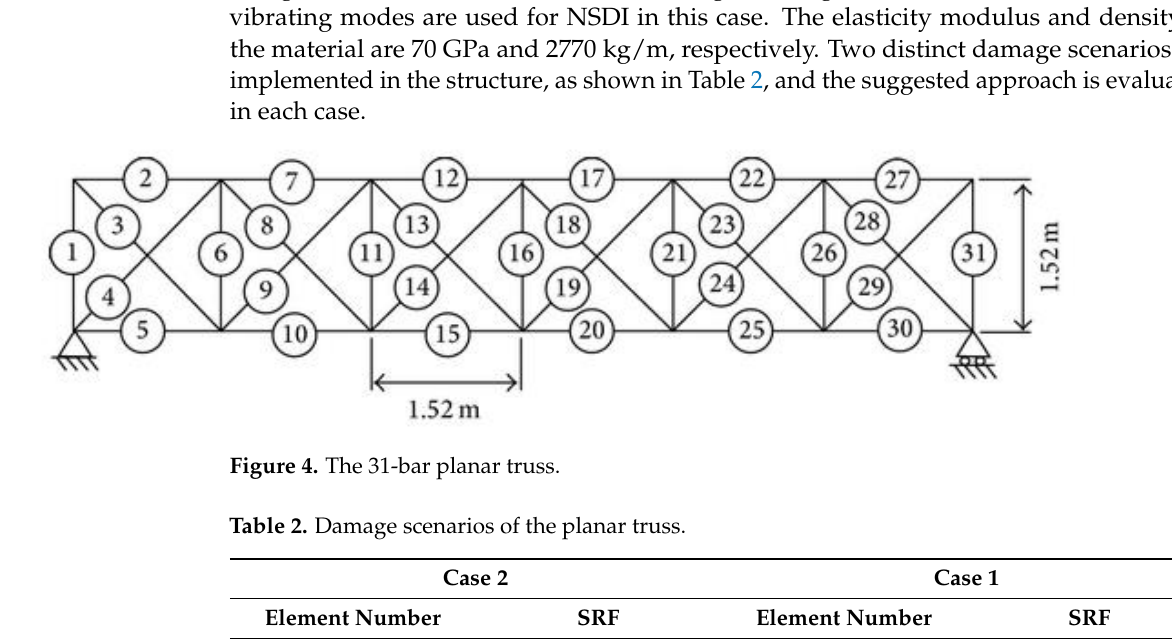
Table 3. PoDEs and DMIs of case 1 for the 31-bar planar truss.